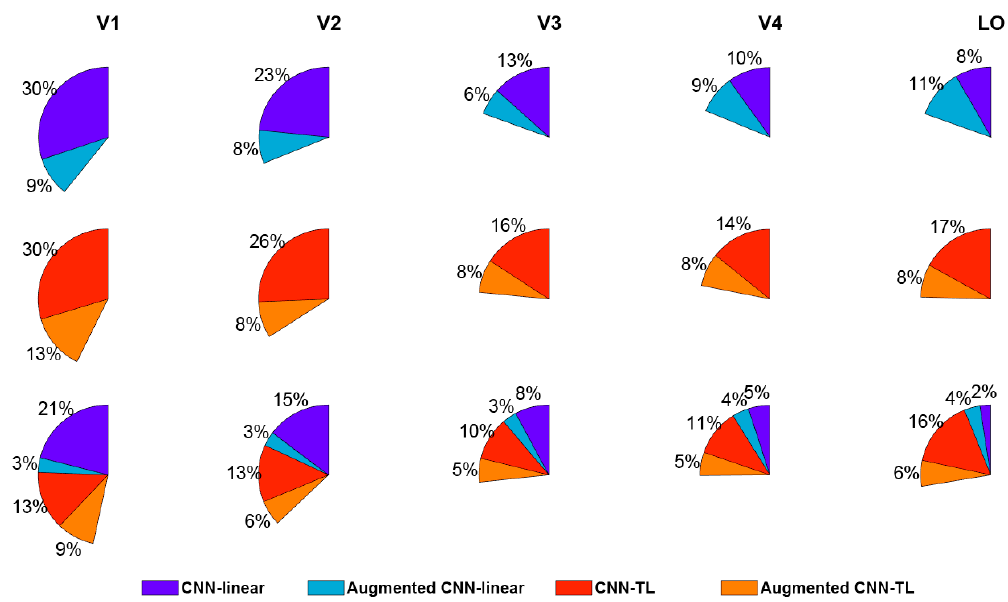
Figure 7. The advantage comparisons of visual encoding models. Each sector shows the proportion of voxels in one ROI, which can be predicted correctly by encoding models for comparison. Each color within sectors indicates the proportion of voxels best predicted by one encoding model. The CNN-linear model, augmented CNN-linear model, CNN-TL model, and augmented CNN-TL model are displayed by dark blue, light blue, red, and orange respectively.